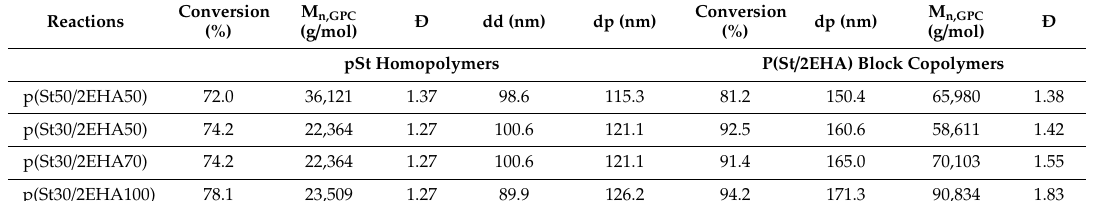
Table 1. Conversion, average particle size (dd: diameter of the droplets; dp: diameter of the particles), Mn, and Ð at the end of reaction for pSt homopolymers and p(St / 2-ethylhexyl acrylate (2EHA)) block copolymers.